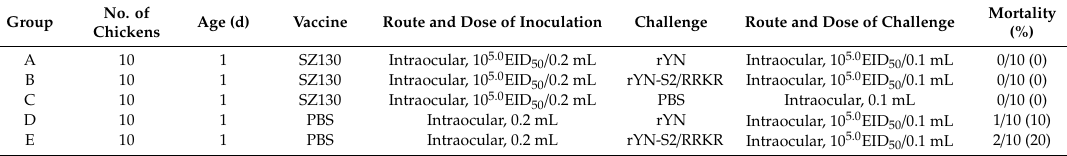
Table 2. Experimental design and results of immunization and challenge